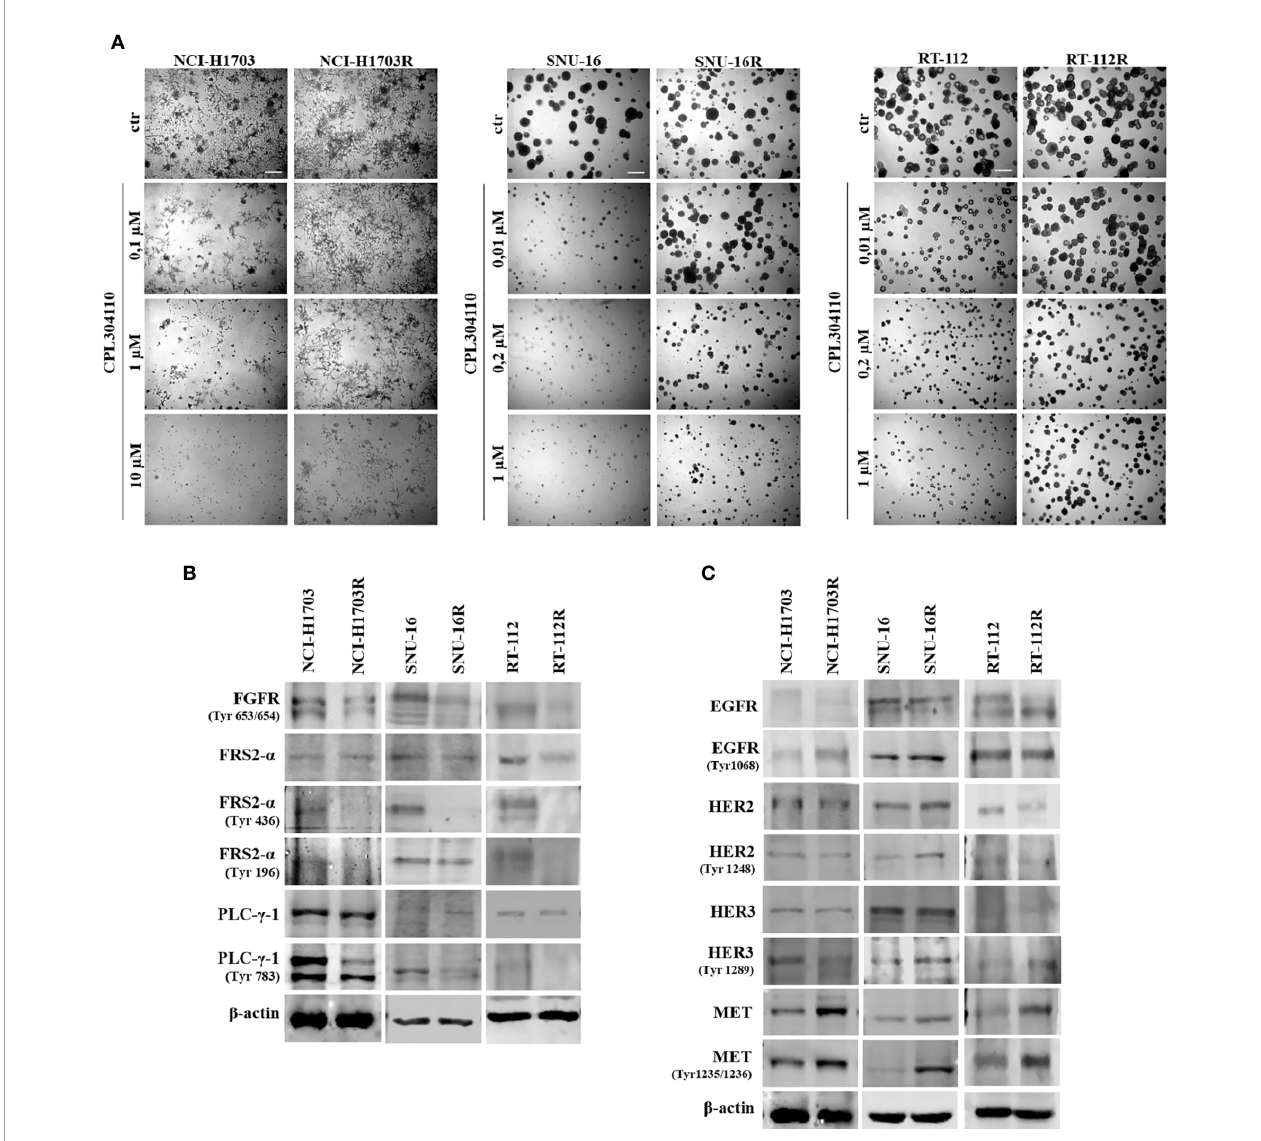
FIGURE 2 | Development of resistance to CPL304110. Resistance to FGFR inhibitor was induced by chronic exposure to CPL304110. (A) Response to CPL304110 of parental and resistant cells was evaluated in 3D Matrigel ® . Representative pictures were taken after 14 days of growth. Scale bar represents 100 µm. Western blot analysis was performed with lysates from parental and resistant cells to assess (B) FGFR signaling and (C) other RTKs expression/activity level. Experiments were conducted in